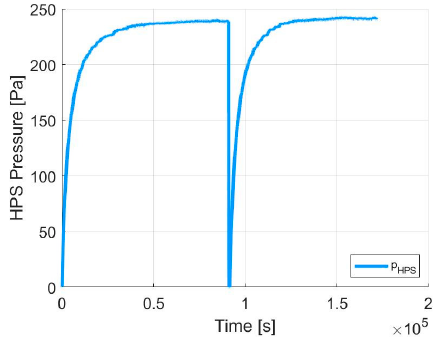
Figure 4. HPS pressure trend in two consecutive measurements.